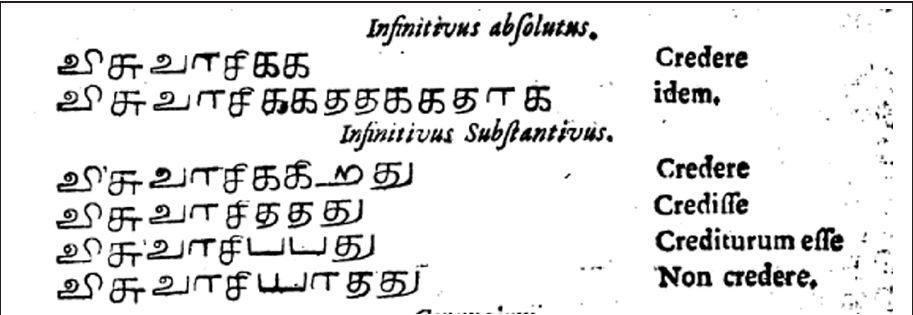
Figure 11: Ziegenbalg (1716: 72) making the distinction between two types of